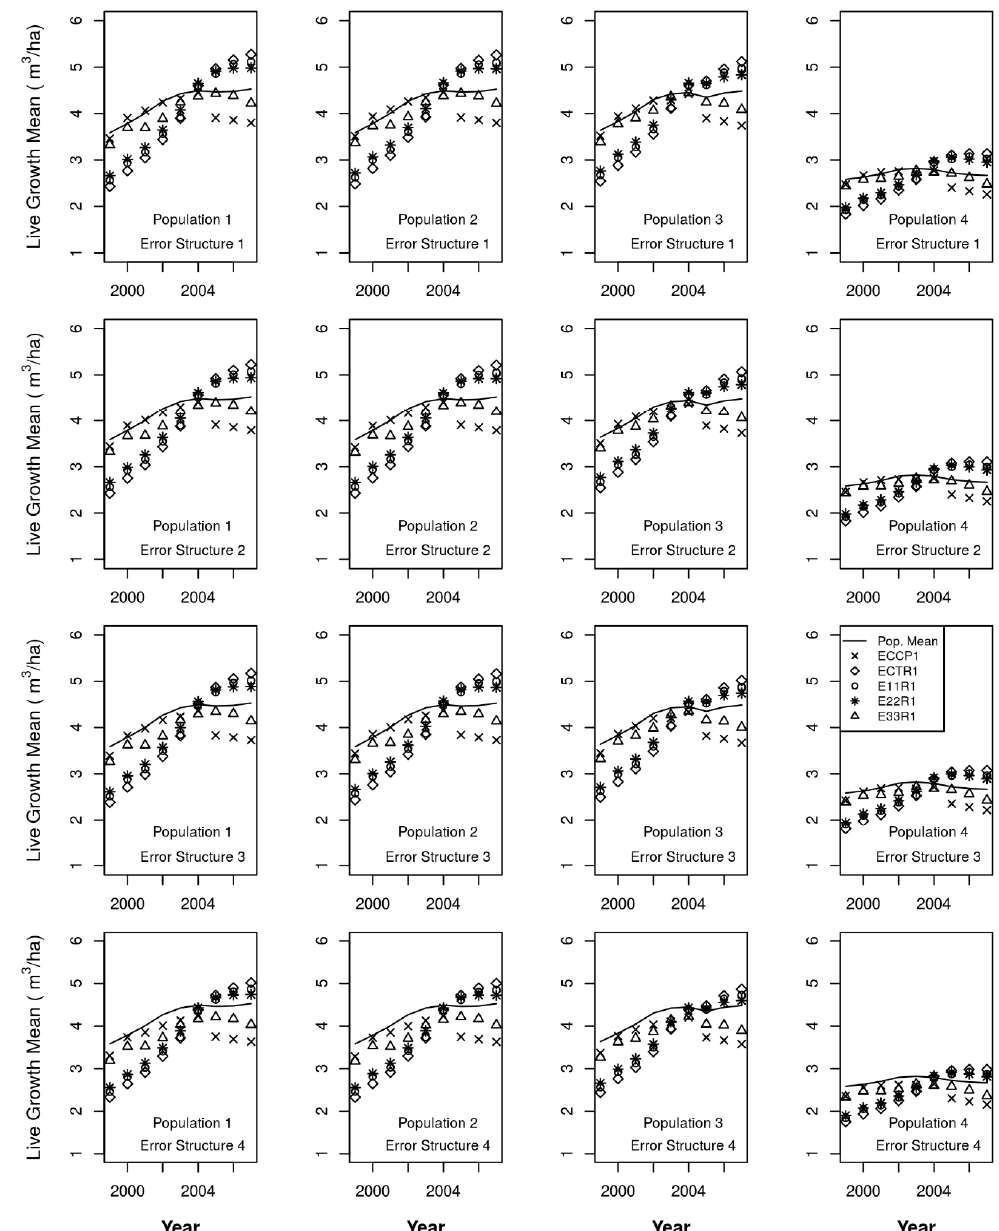
Figure 1. The means of five live growth estimators including the centralized mean (ECCP1), the trend ‐ distributed estimator (ECTR1), and the three ICE ‐ enhanced estimators under availability levels A1, A2, and A3 relative to the population mean for live growth, over 1000 iterations of 1000 samples for each population and sample error structure.